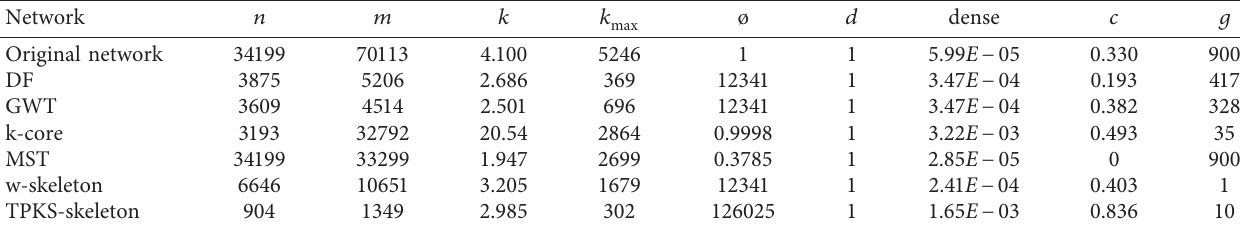
Table 4: Topological features of the original network compared with the skeleton network.